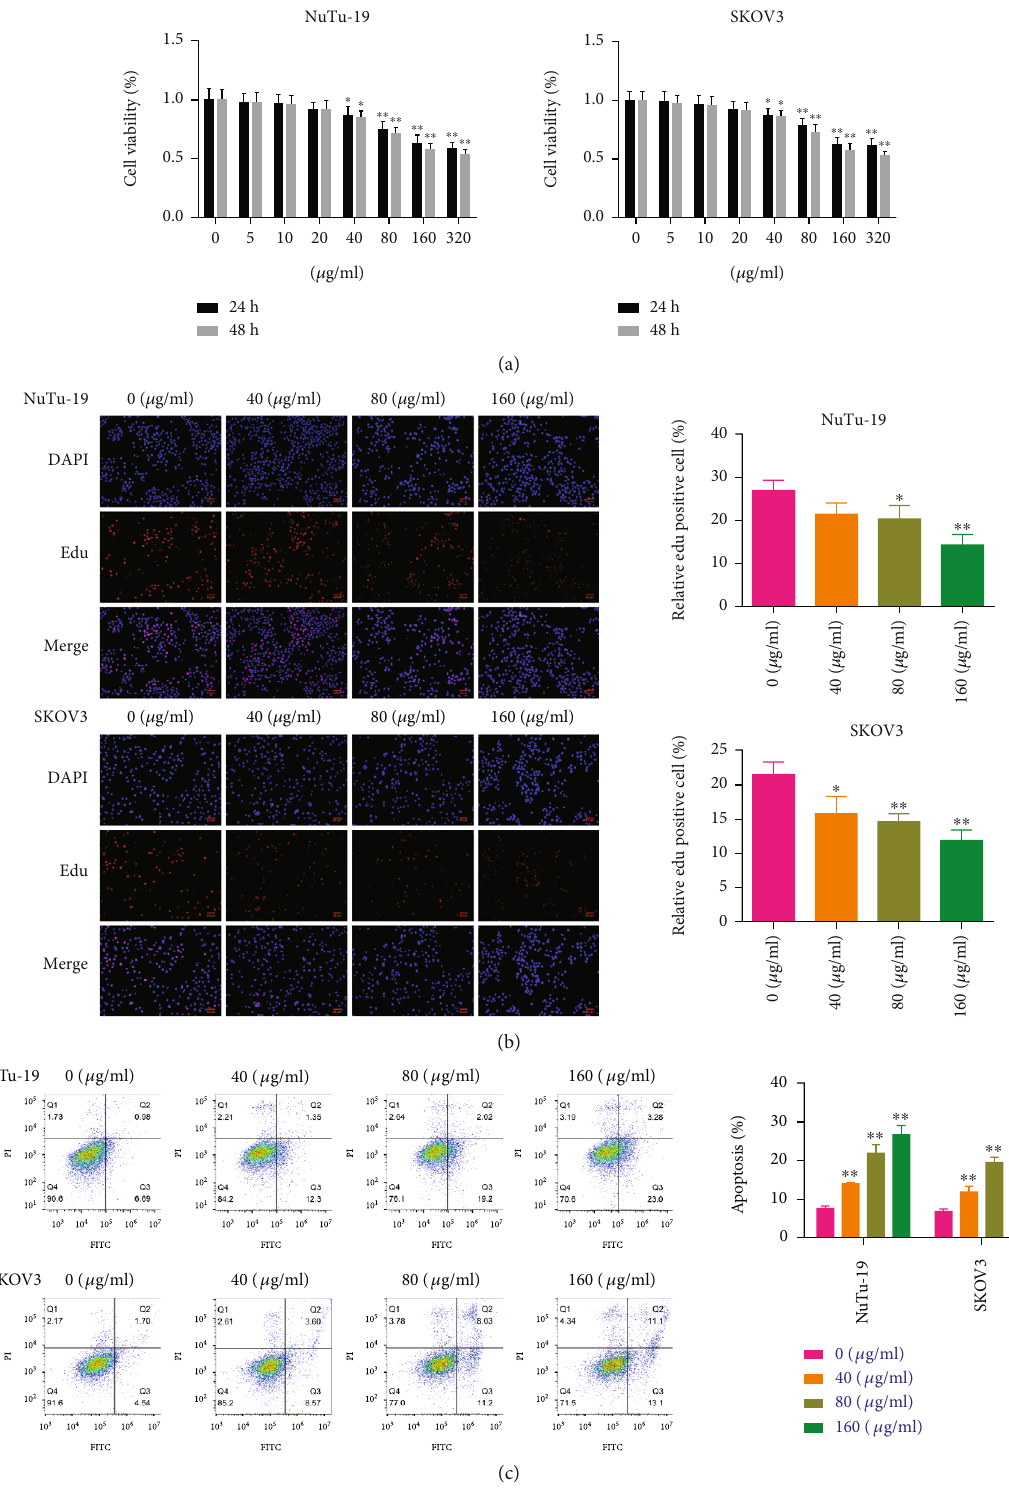
Figure 1: Puerarin inhibits OC cell proliferation and induces cell apoptosis. (a) OC cell lines NuTu-19 and SKOV3 were coincubated with increasing concentrations of puerarin (0-320 μ g/mL) for 24h and 48h, and CCK-8 assay was performed to detect the cell viability. (b) NuTu-19 and SKOV3 cells were coincubated with 0, 40, 80, and 160 μ g/mL of puerarin, and cell proliferation was detected using EdU staining. (c) Cell apoptosis rates of NuTu-19 and SKOV3 cells were assessed by Annexin V-FITC/PI staining with fl ow cytometry. The data are presented as mean ± SD , n = 3 . ∗ p < 0 : 05 , ∗∗ p < 0 : 01 , compared to the 0 μ g/mL puerarin group. OC: ovarian